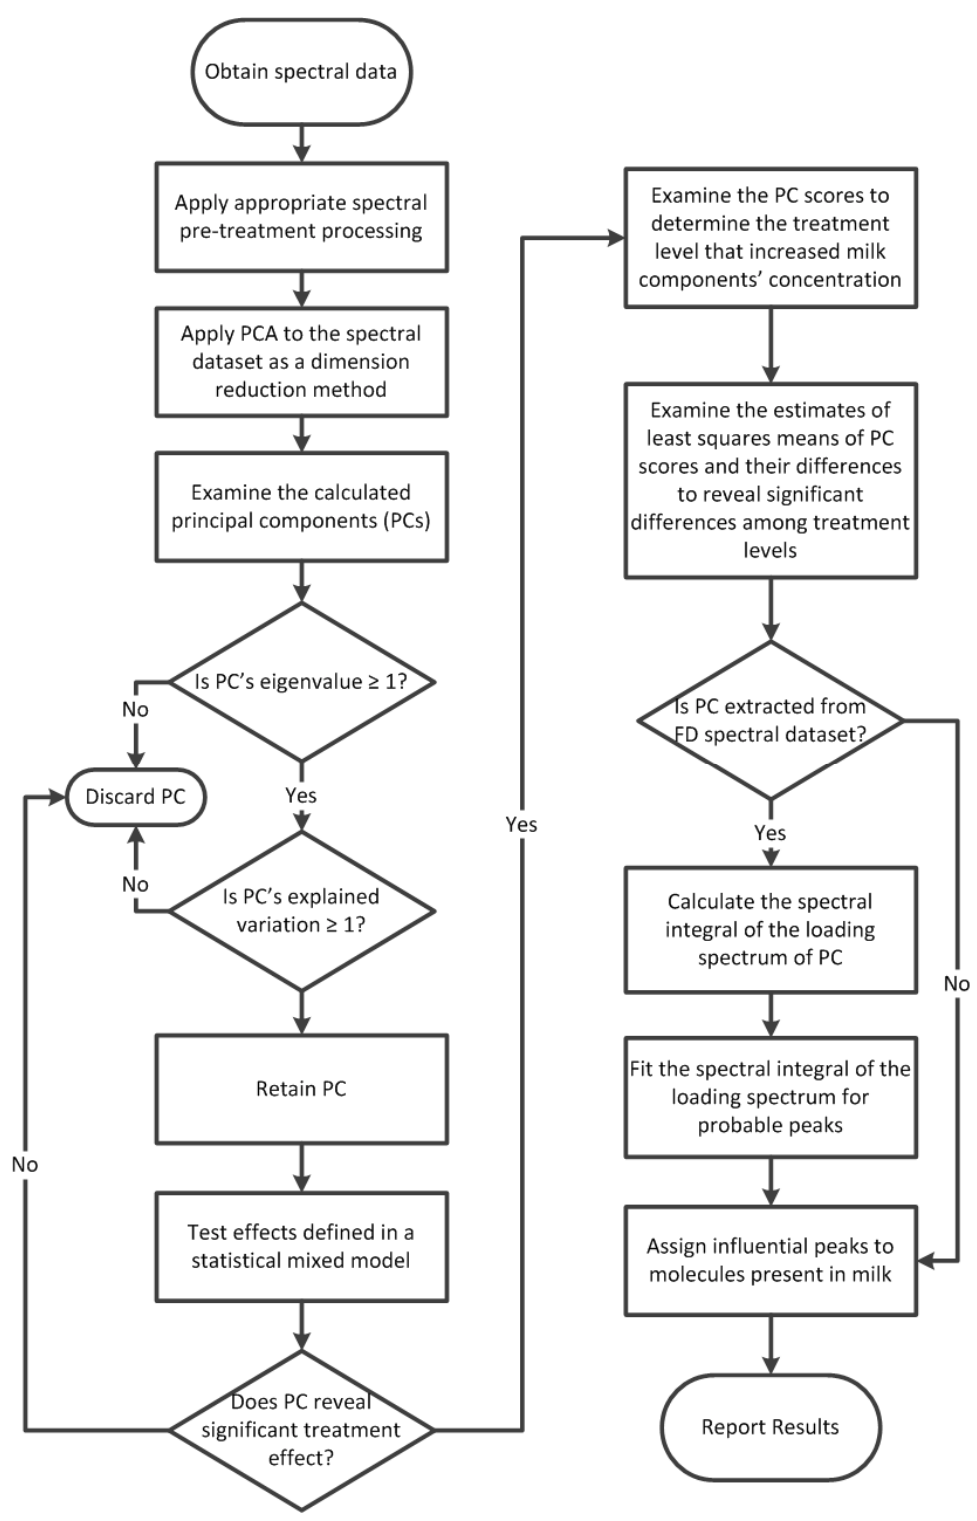
Figure 1. Workflow of the hybrid data analysis approach of the FTIR milk spectral data to detect a treatment effect. PCA = principal component analysis, PC = principal component, FD = first derivative.